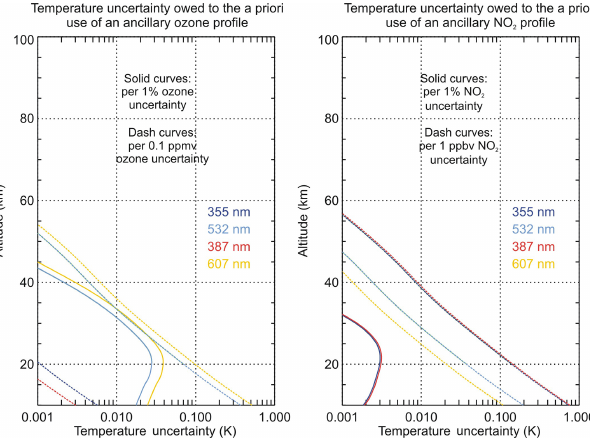
Figure 8. Temperature uncertainty owing to a priori use of ancillary temperature to tie-on at the start of the density integration process. The results are shown per 1K ancillary temperature